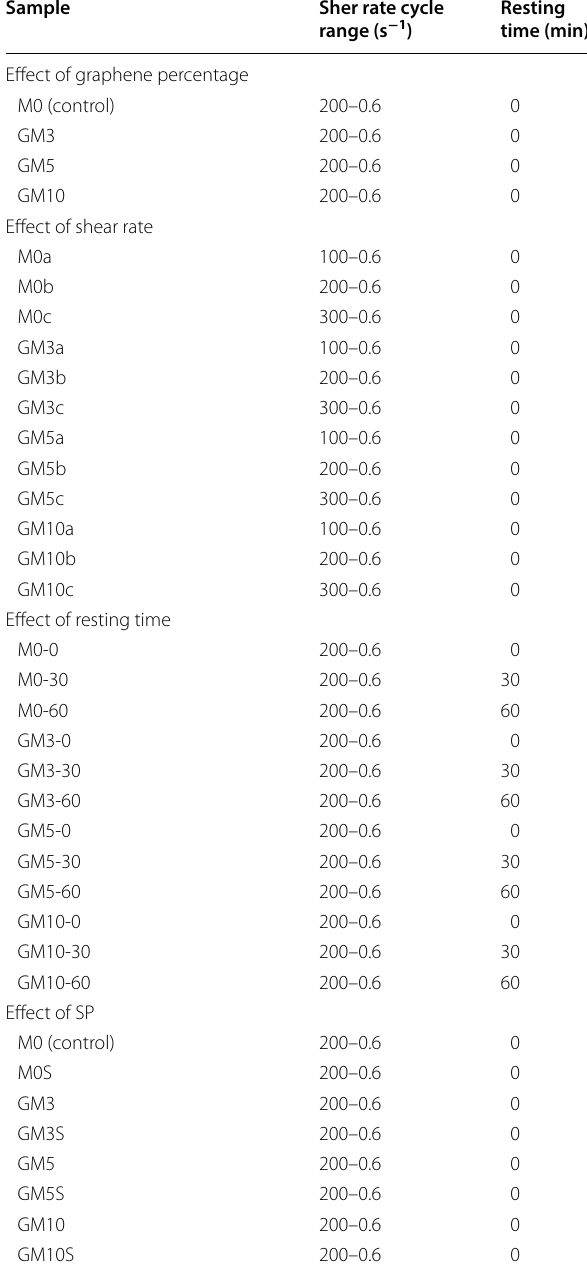
Table 3 Description of rheological